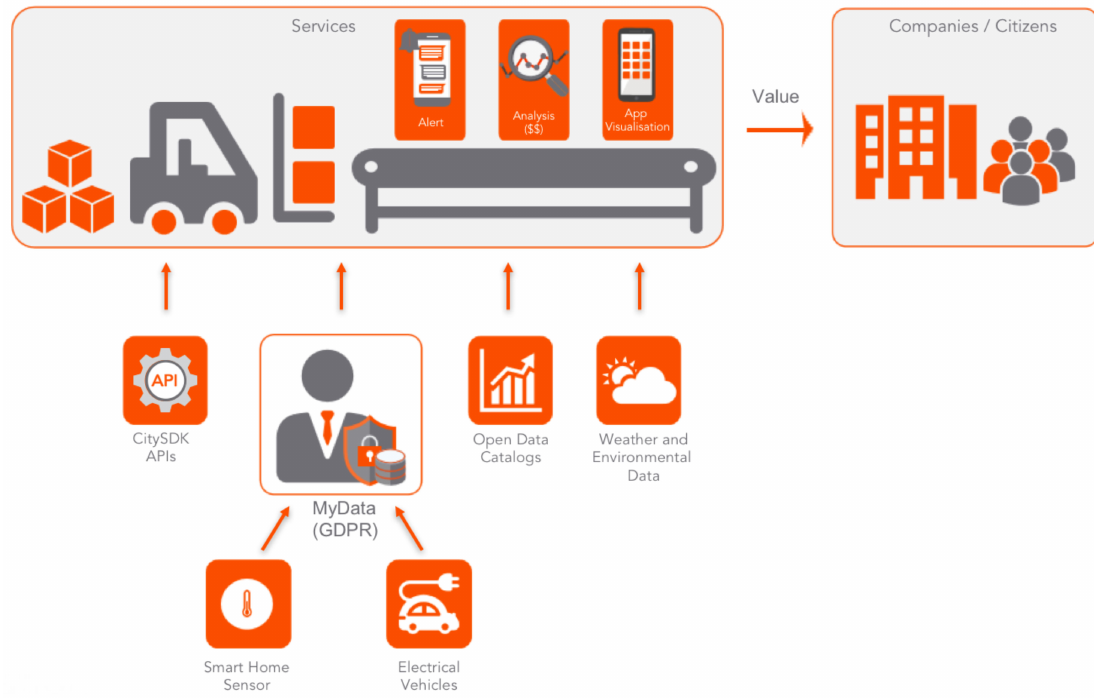
Figure 8. Helsinki urban platform reference architecture under the City-as-a-Platform concept. Table 3. Mapping the Open Specifications Framework and Helsinki Urban